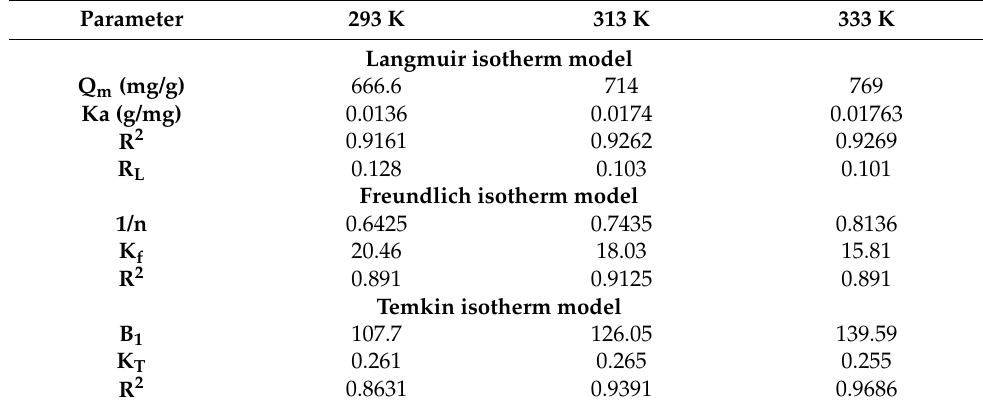
Table 3. Different isotherm parameters for adsorption of AO-8 on Pd-Ni/AC-CeO 2